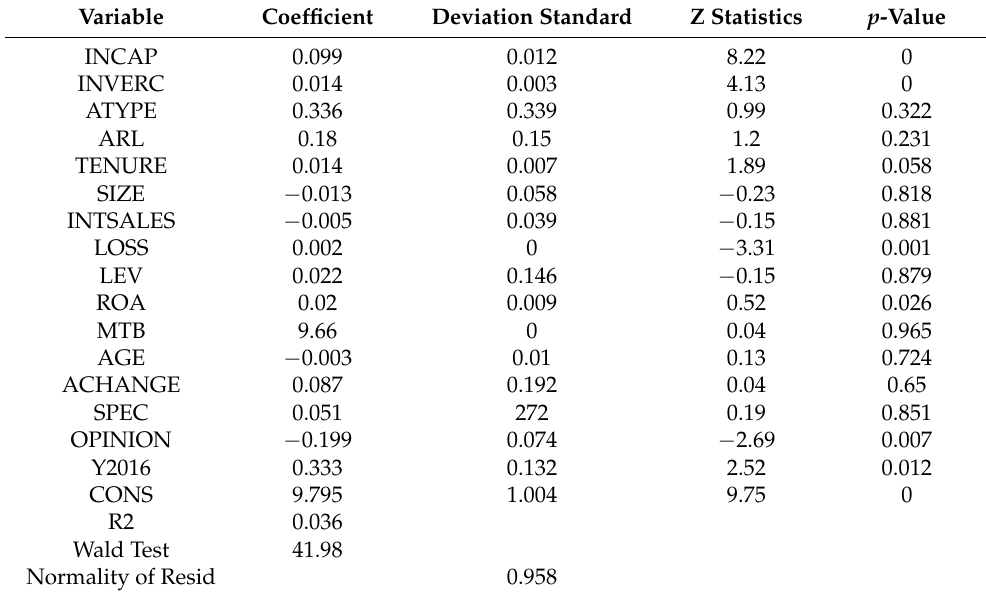
Table 4. The results of estimating the first model by the stochastic effects